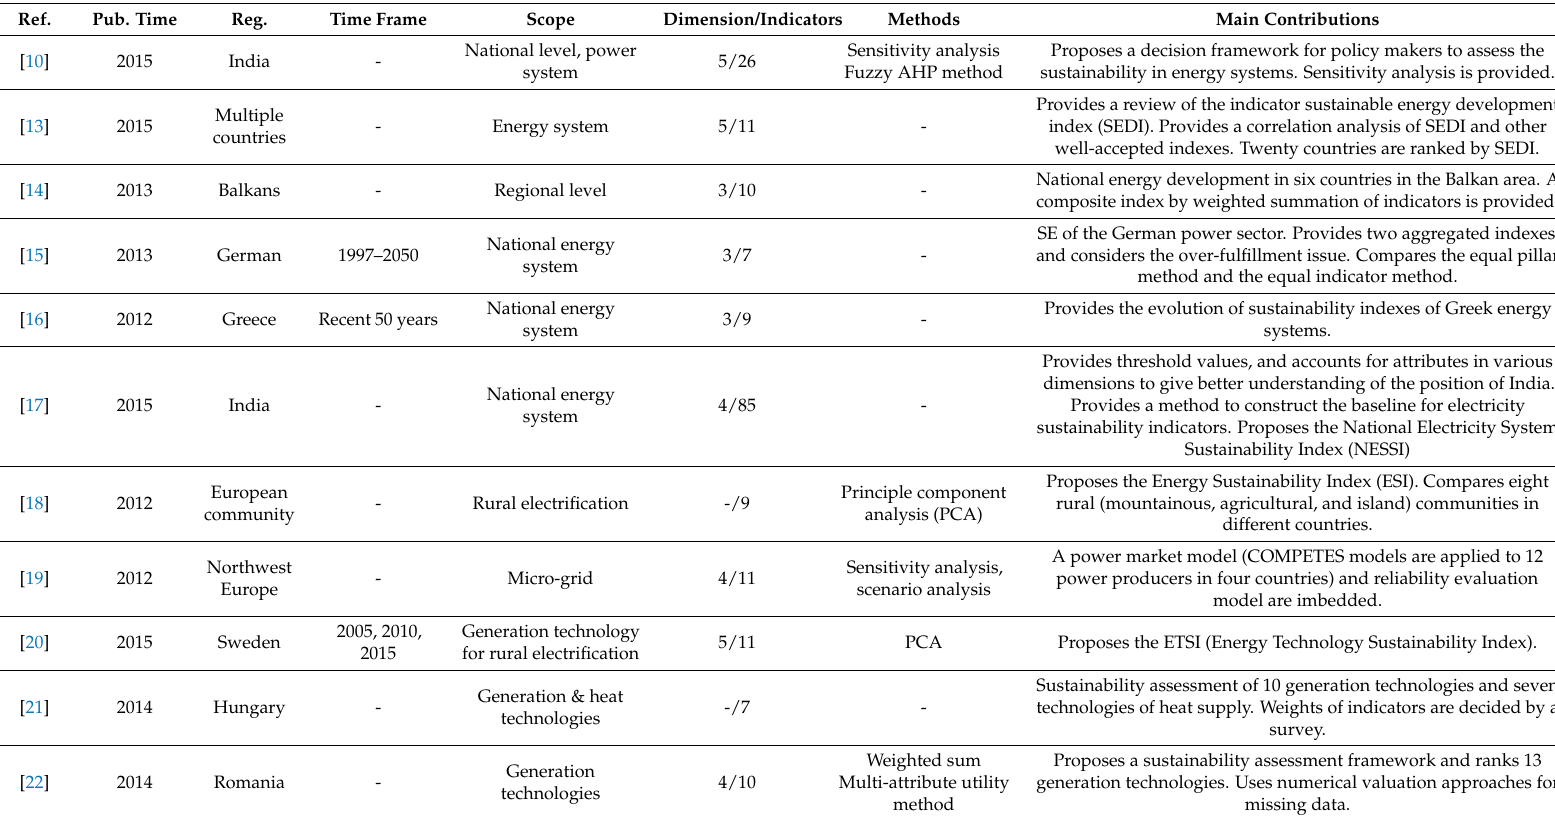
Table 1. An introduction of works in the sustainability evaluation of power system-related fields [Adapted with permission from [6], Chenjun Sun, etc., IEEE Proceedings, IEEE, 2016.]